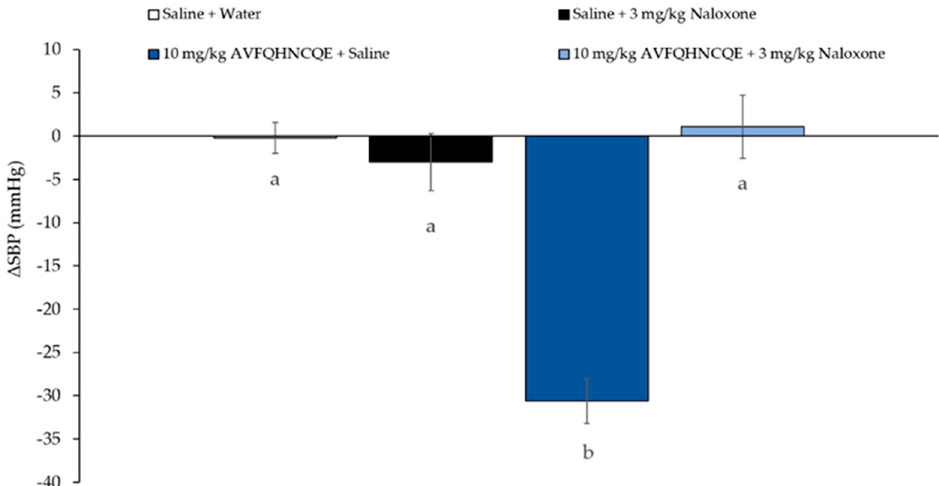
Figure 1. Changes in systolic blood pressure (SBP) caused in spontaneously hypertensive rats after 6 h post-administration of the di ff erent treatments: oral administered water + intraperitoneal injected saline, oral administered water saline + intraperitoneal injected 3 mg / kg bw Naloxone, oral administered water 10 mg / kg bw AVFQHNCQE + intraperitoneal injected saline or oral administered water 10 mg / kg bw AVFQHNCQE + intraperitoneal injected 3 mg / kg bw Naloxone. Data are expressed as mean ± standard errors. The experimental groups always had six animals each. Di ff erent letters represent statistically significant di ff erences ( p < 0.05). P was estimated by one-way ANOVA.